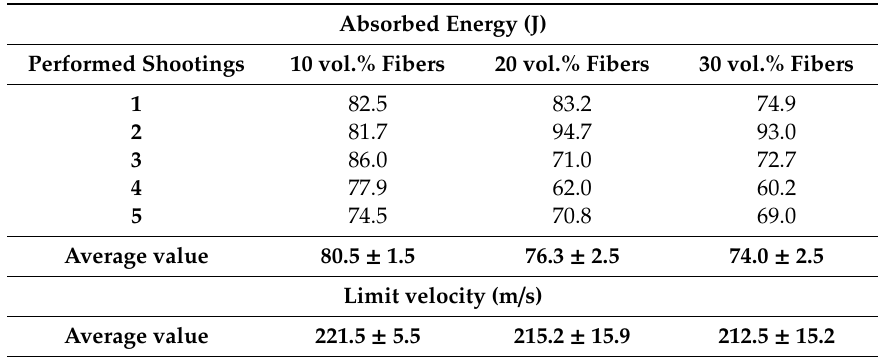
Table 10. Absorbed energy in the ballistic test and limit velocity for the epoxy resin and for the CM sedge fiber-reinforced composites.